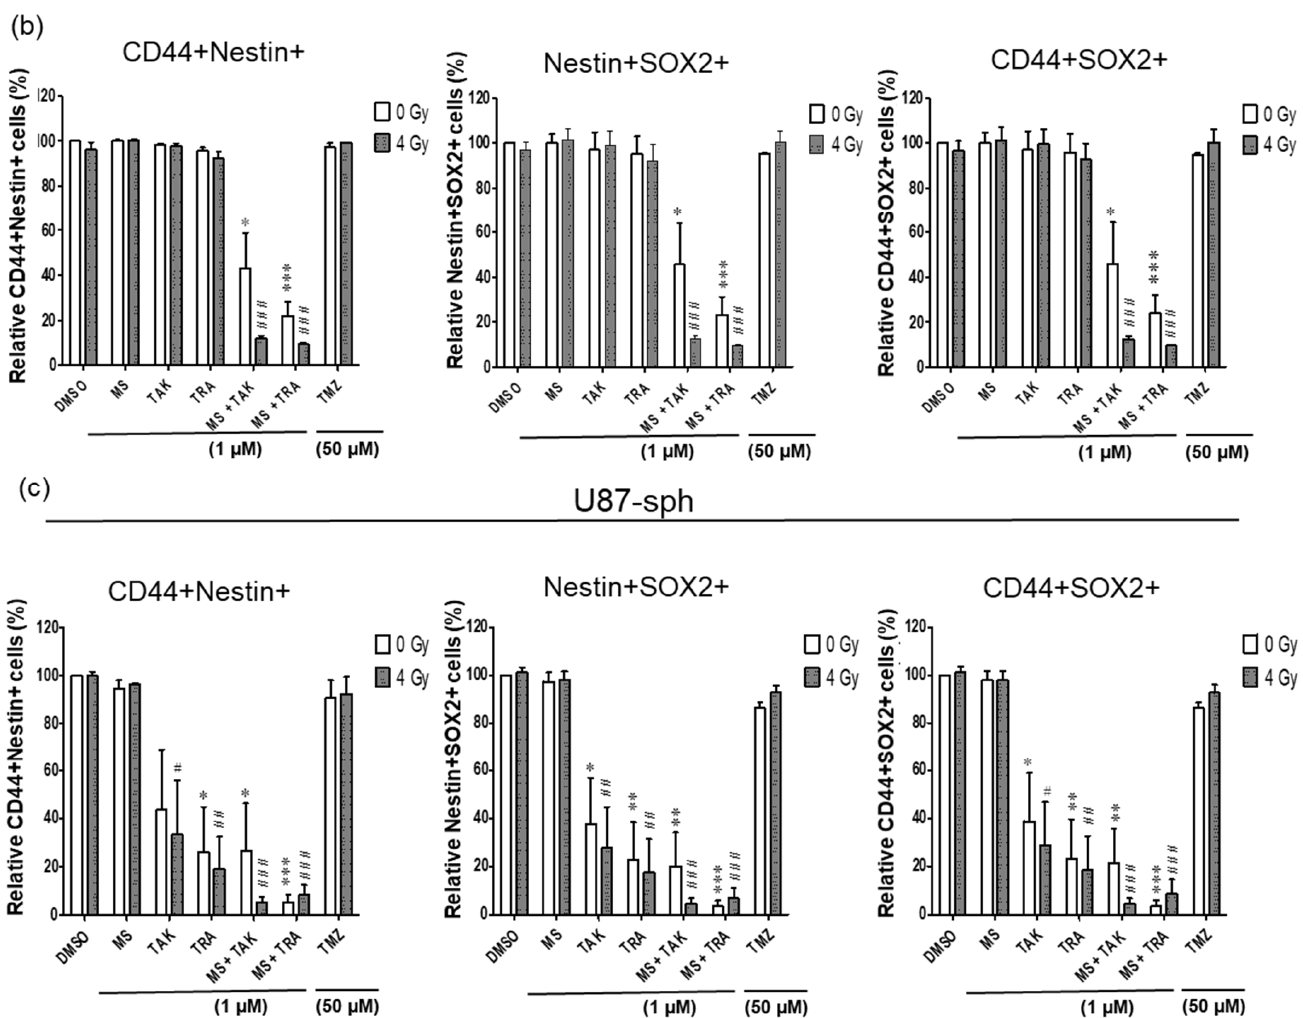
Figure 6. Double expression of GSLC markers reduced by the combination of HDAC and MEK inhibitors with radiation. ( a ) Representative example of flow cytometric plots in U251-sph 72 h after the spheres were treated with HDCAi (1 µM MS-275), MEKi (1 µM TAK-733 or 1µM trametinib), a combination of both (1 µM MS-275 + 1 µM TAK-733 or 1 M MS-275 + 1 µM trametinib) and 50 µM TMZ alone or with 4 Gy radiation. Percentages of double-positive cells for CD44 and Nestin (CD44+Nestin+; upper-right quadrant) after the indicated treatment conditions are shown. Values inside each plot represent the percentage of single cells from a total of approximately 2 × 10 4 cells acquired. ( b ) Quantification of CD44+Nestin+, Nestin+SOX2+ and CD44+SOX2+ relative to sham- irradiated control cells (DMSO) set to 100% in U251-sph and ( c ) U87-sph. Data represent means ± SEM ( n = 3). Asterisks indicate significant differences between 0 Gy DMSO and treated samples using Student’s t -test: * p ≤ 0.05, ** p ≤ 0.01 and *** p ≤ 0.001, while hash symbols indicate significant differences between 4 Gy DMSO and 4 Gy treated samples using Student’s t -test: # p ≤ 0.05, ## p ≤ 0.01 and ### p ≤